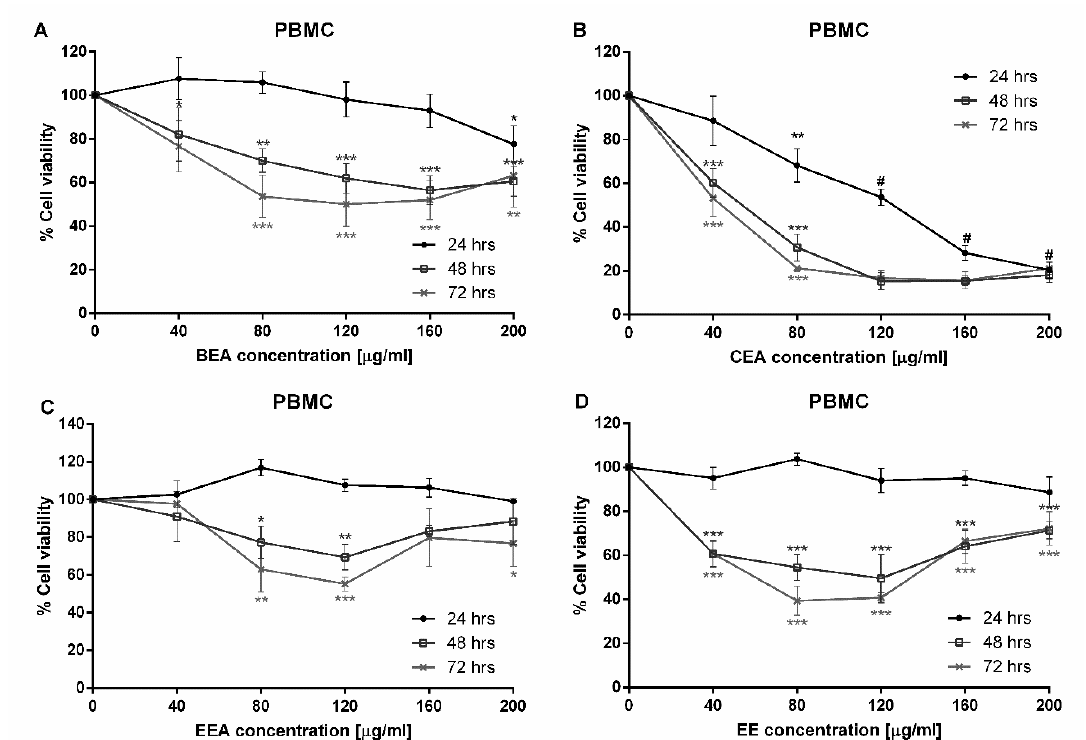
Figure 2. Cytotoxic e ff ect of the e ff ective extracts against PBMCs. PBMCs were separated and treated with the e ff ective extracts; ( A ) BEA, ( B ) CEA, ( C ) EEA, and ( D ) EE for 24, 48, and 72 h at various concentrations on the X -axis. The data are reported as mean ± SD of three independent experiments carried out in triplicate, * p < 0.05, ** p < 0.01, *** p < 0.001 and # p < 0.001 for all incubation times compared to the control condition.